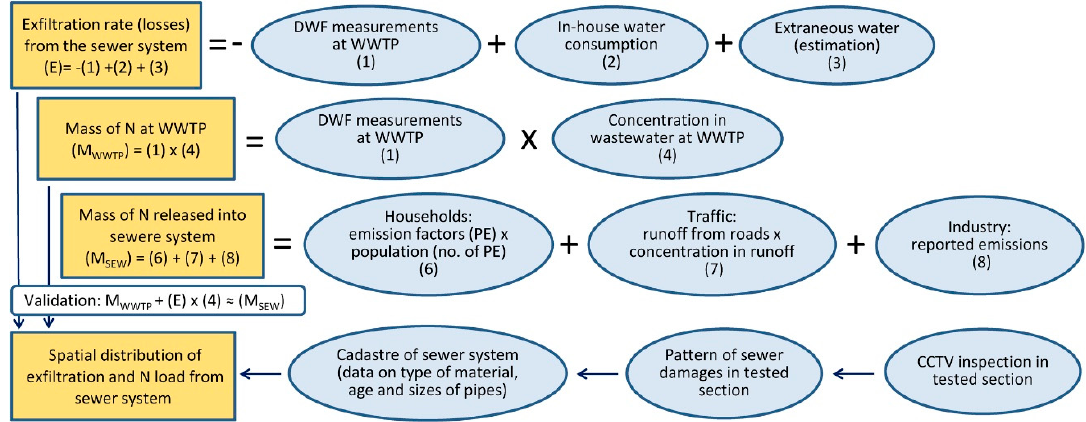
Figure 3. The flowchart of the workflow for the estimation of nitrogen (N) load from the sewer system (adapted after Pestotnik et al., 2019